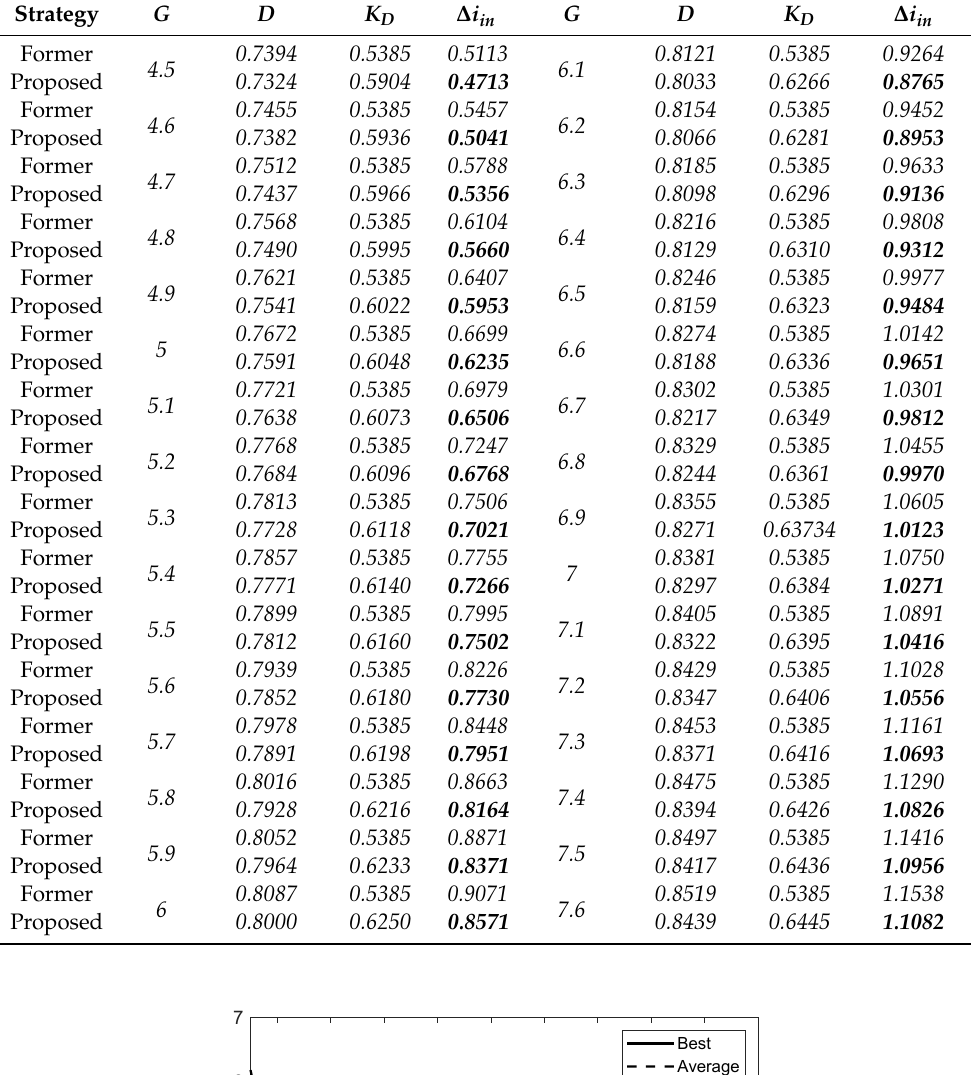
Table 5. Performance of the former strategy and the proposed method.